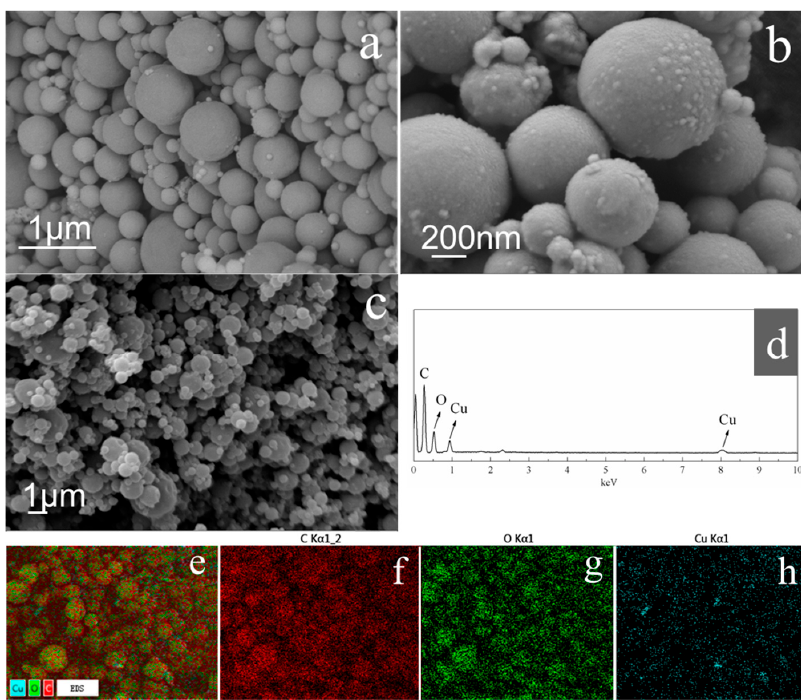
Figure 1. SEM images of lignin nanospheres and Cu 2 O@L: ( a ) electrosprayed lignin nanospheres; ( b ) Cu 2 O@L; ( c ) lignin nanosphere after carbonization at 800 °C under N 2 atmosphere; ( d ) the EDS of Cu 2 O@L; ( e ) EDS mapping images of C, O, and Cu elements; and ( f ) C element, ( g ) O element, and ( h ) Cu element EDS mapping, respectively.